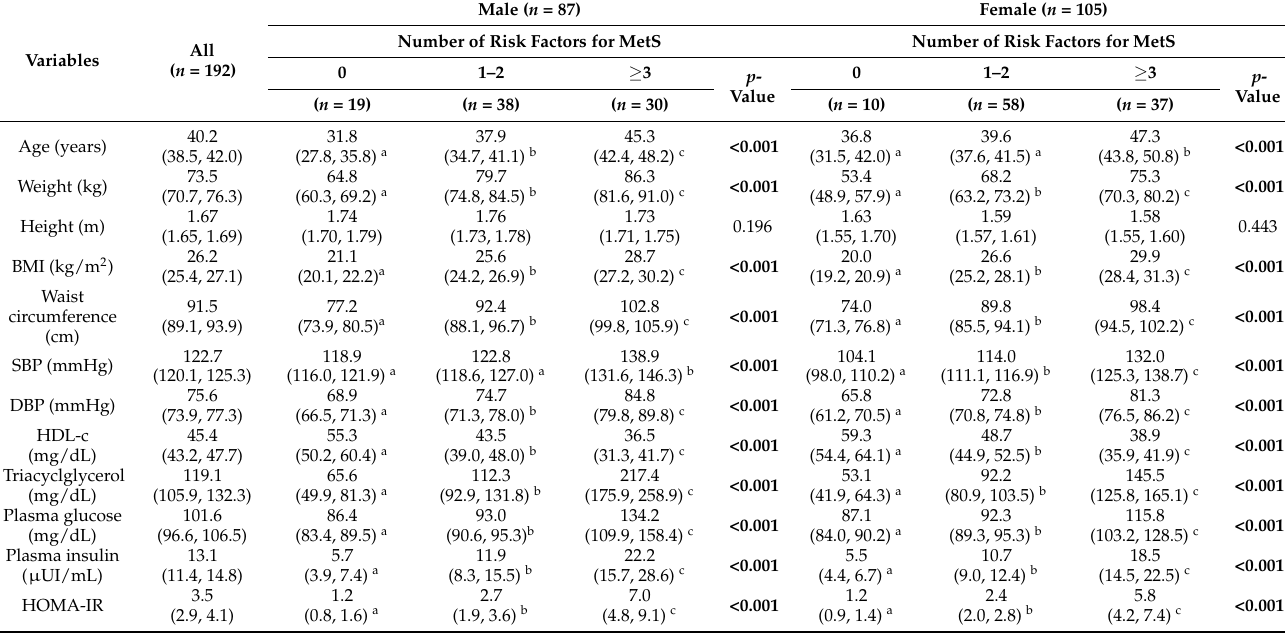
Table 1. Demographic and clinical characteristics of all study participants from a population-based study and for males and females separately grouped by number of metabolic syndrome (MetS)